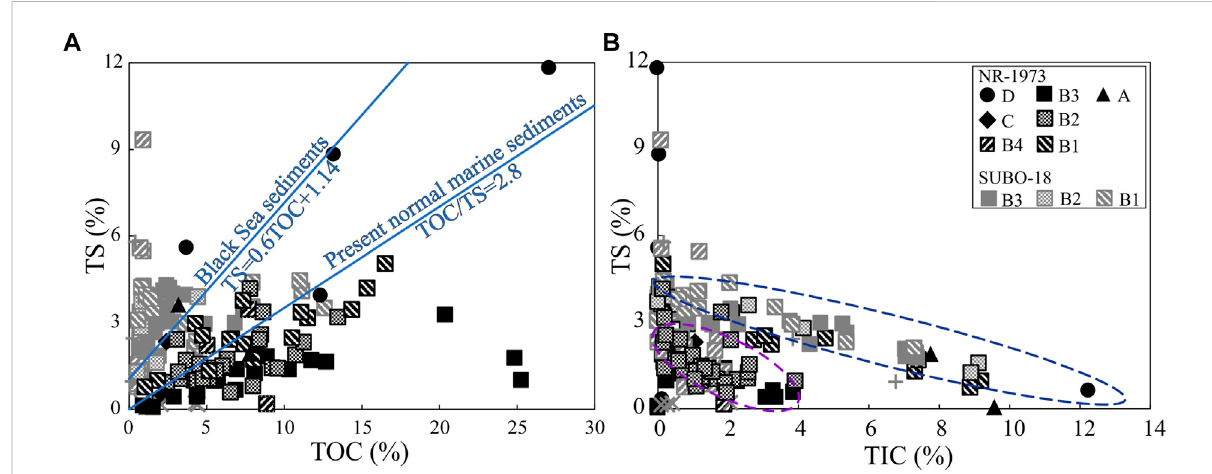
FIGURE 13 Crossplots of TS vs (A) TOC and (B) TIC of the post-impact sediments in the Nördlinger Ries. TS=total sulphur content, TOC=total organic carbon content, TIC=total inorganic carbon content. See Figure 2 for stratigraphic